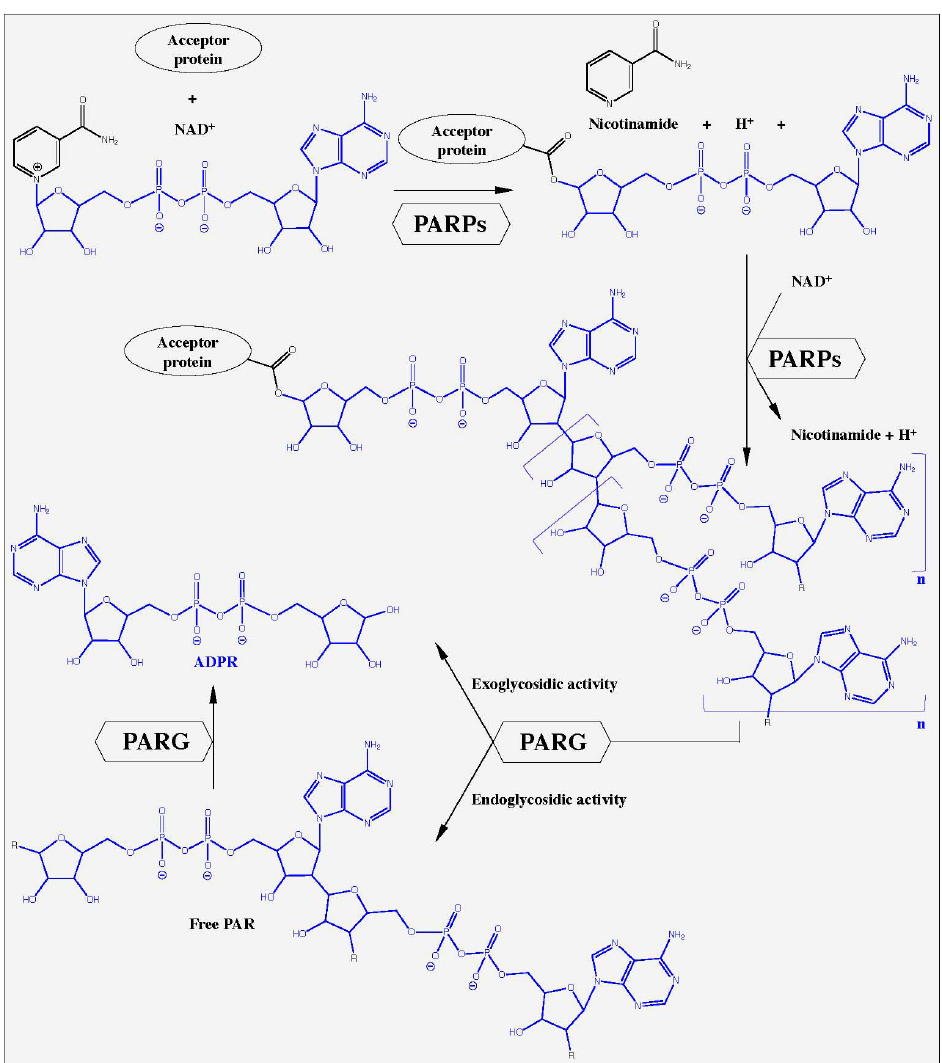
1. Poly(ADP-ribose) metabolism. In response to DNA damage, nuclear poly(ADP-ribose)polymerases (PARP-1 and PARP-2) hydrolyze NAD + , releasing ADPR, nicotinamide and H + . This reaction is induced by the formation of an ester bond between the amino acid-acceptors glutamic acid, aspartic acid or COOH-lysine and the first ADP-ribose (ADPR, marked in blue). Elongation occurs at the 2 ′ -OH of the ribose moiety whereas branching occurs at the 2 ″ -OH position resulting in poly(ADPR) (PAR), a multi-branched polyanion. Poly(ADPR)glycohydrolase (PARG) is a catabolic enzyme with an endo- and exoglycosidic activity. It cleaves the glycosidic bonds between the ADPR units, resulting in free PAR and finally